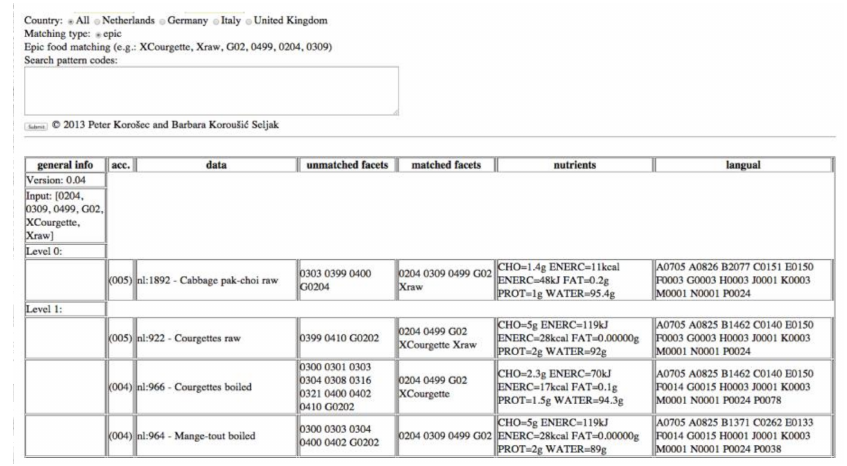
Figure 3. GloboDiet to LanguaL food matches.